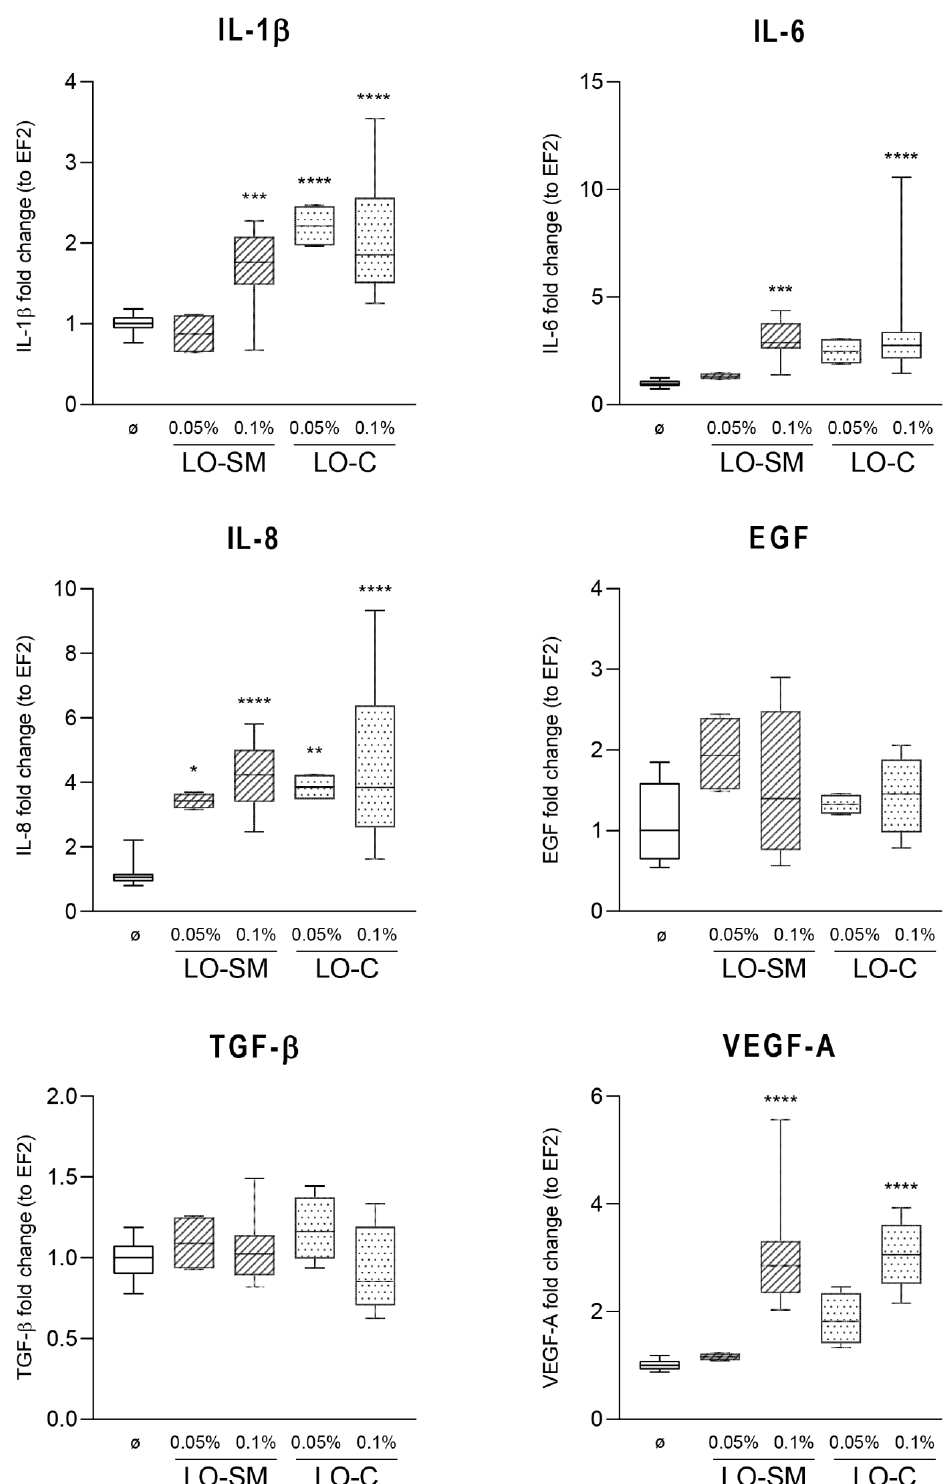
Figure 3. Effect of lavender oil stimulation on the expression level of cytokines in HaCaT cell line. HaCaT cells were stimulated with designated concentrations ( v / v ) of commercial or in-house preparation of lavender oil for 4 h. Levels of mRNA production of cytokines: IL-1 β , IL-6, IL-8, EGF, TGF- β , and VEGFA were verified with RT-PCR. Values are mean with range. Groups were compared to the control, and statistical analysis was performed using GraphPad Prism and build-in ANOVA test. p -values ≤ 0.05 were considered significant. *— p = 0.05–0.011; **— p ≤ 0.01; ***— p ≤ 0.001; ****— p ≤